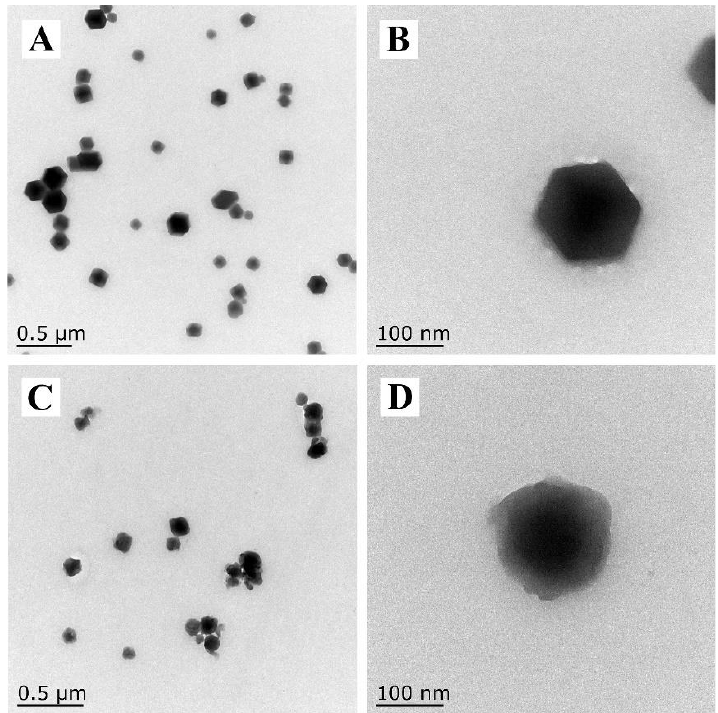
Figure 2. TEM images of ZIF-90 ( A ) ZIF-90-KSM ( C ). The images of ( B ) and ( D ) are higher magnification of TEM images of ( A ) and ( C ).